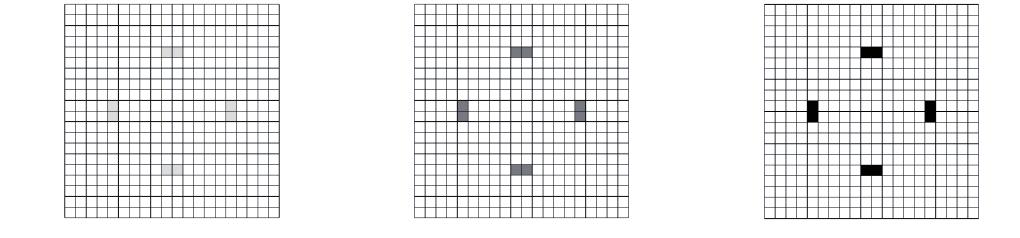
Figure 2. Plate problem, macroscale analysis: plane (top) view of the optimal sensor placement corresponding to (from left to right): N M = 1, N M = 4 and N M =